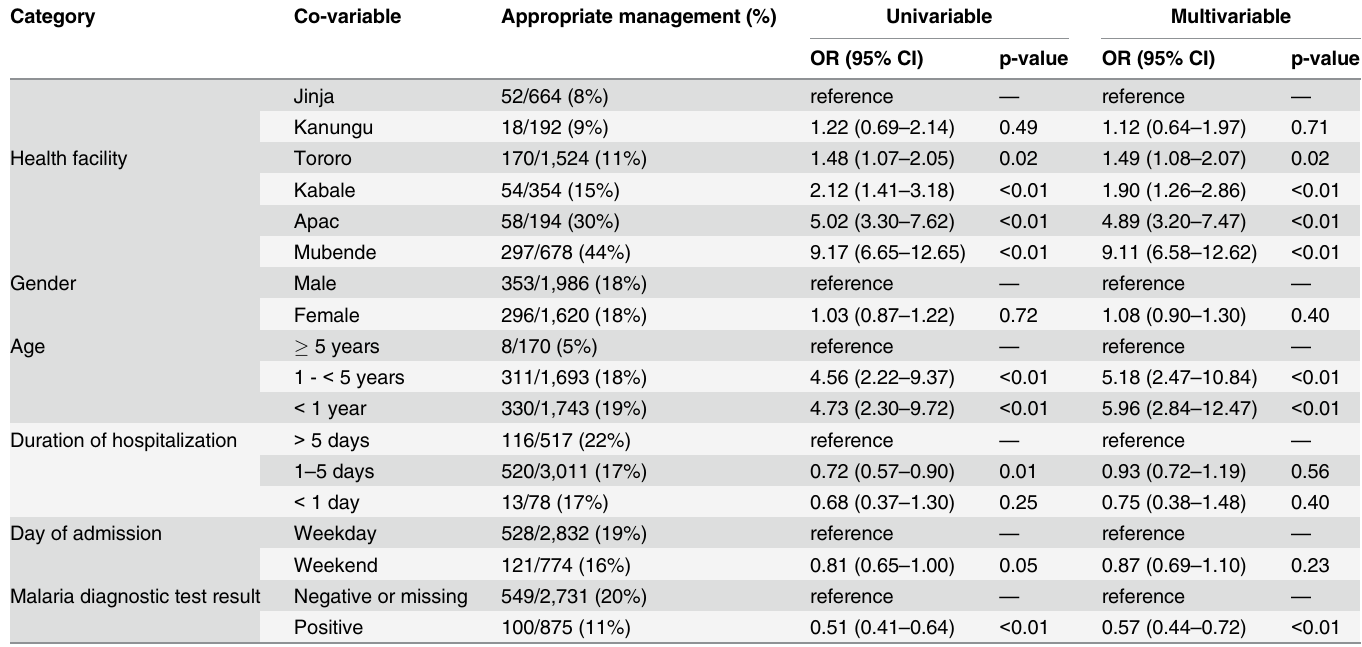
Table 7. Associations between characteristics and receipt of appropriate inpatient case management for diarrhea.